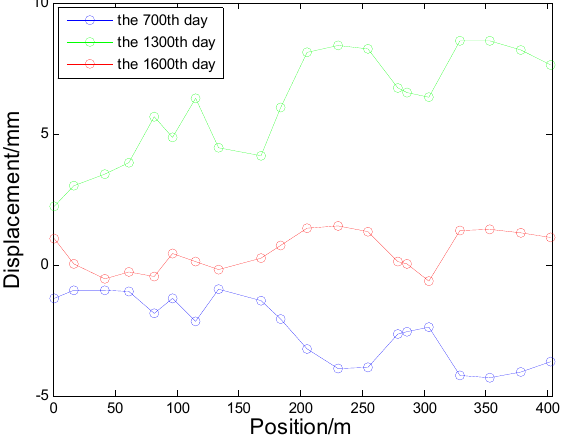
Figure 5. Displacement data on the 700th, 1300th, and 1600th day.